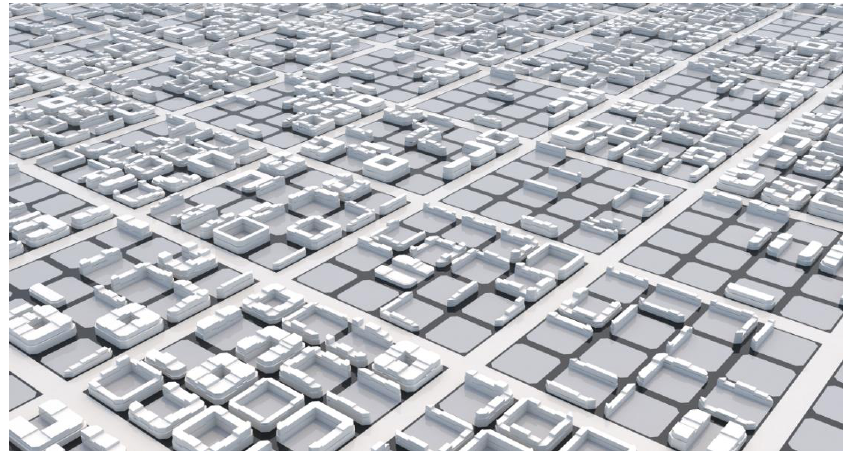
Figure 13. 3D aerial view render from generation-100.